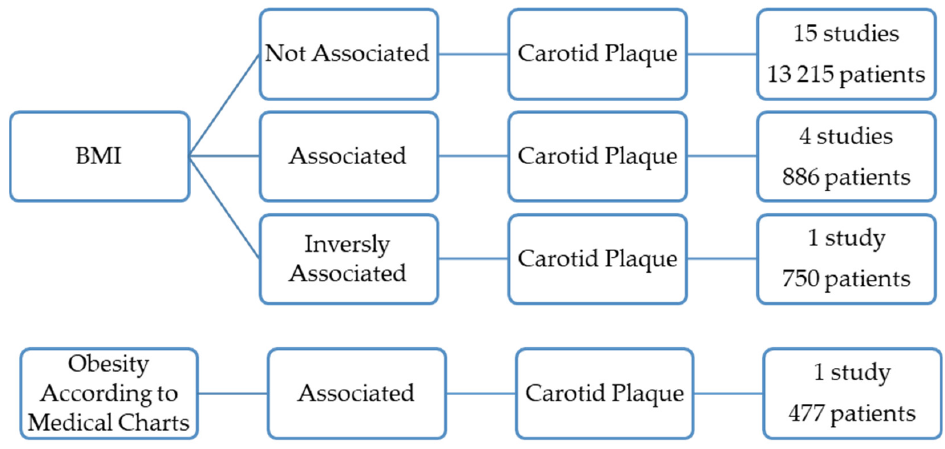
Figure 2. Results of the studies that correlate overall obesity with the presence of the carotid atherosclerotic plaques .